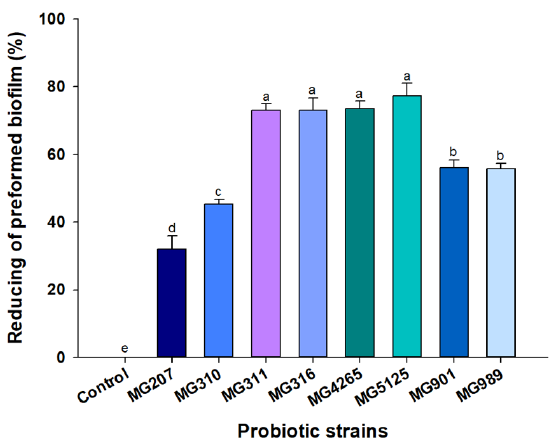
Figure 2. Reducing activity of SCSs of probiotic strains on S. mutans -induced biofilm. Different letters (a–e) indicate significant difference at p < 0.05.